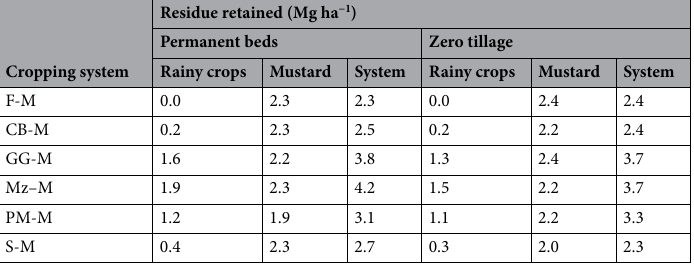
Table 8. Total residue load under different tillage and cropping system over the years.